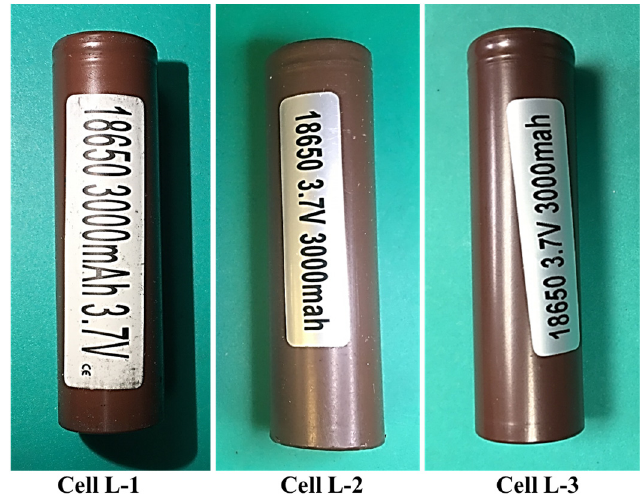
Figure 4. LG Chem 18650 batteries with different labels.